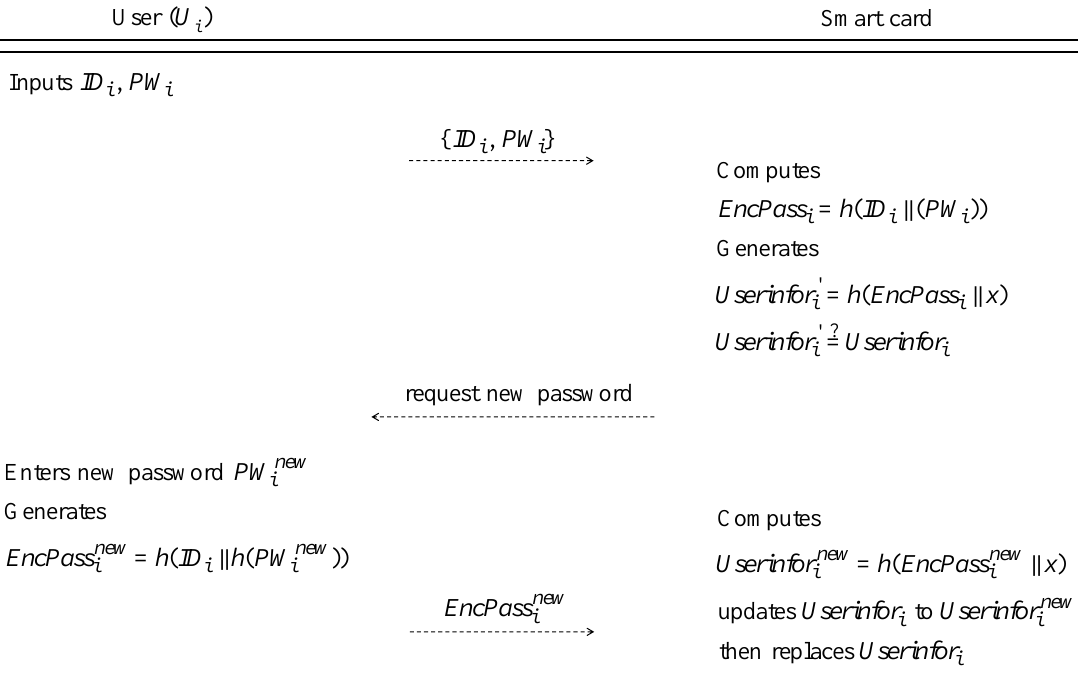
Figure 4. Password change phase of Bae et al.’s